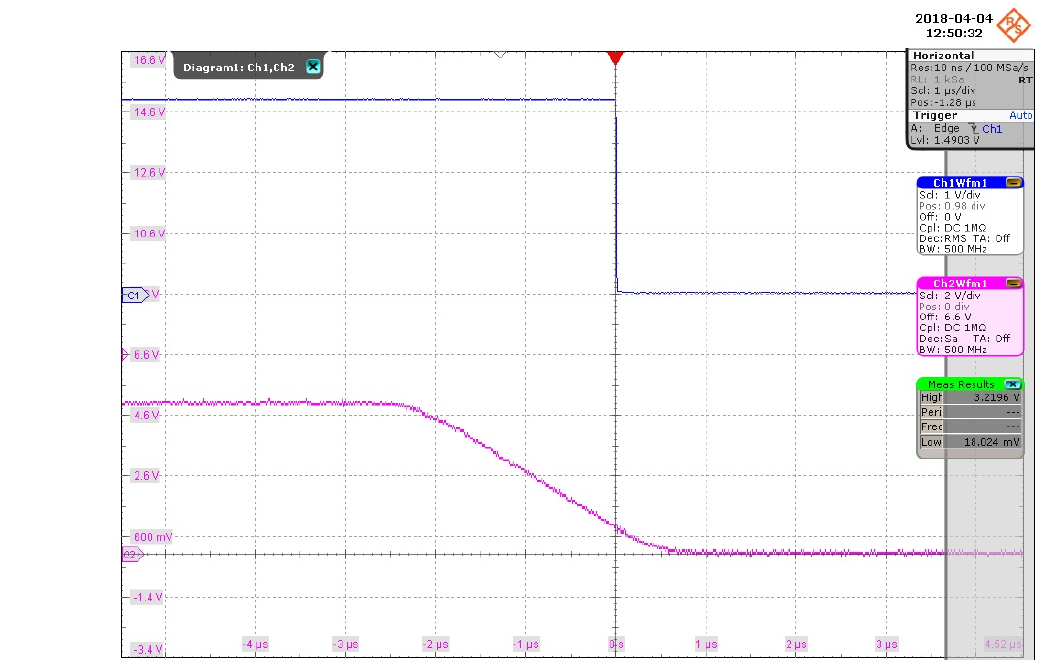
Figure 7. Comparison of timing behaviour for SENT transmission via dual-mode radio (blue line) and via cable (purple